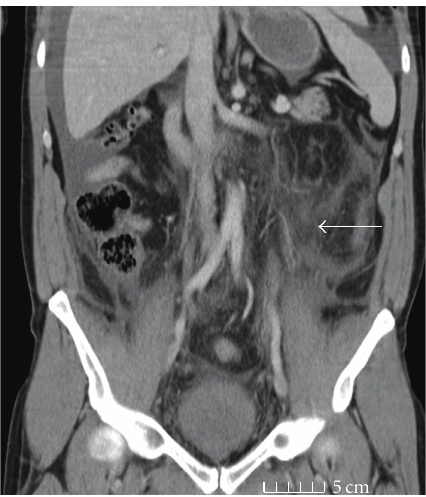
Figure 1: Coronal computerised tomography image showing di ff use inflammation a ff ecting the peritoneum of the left side of the abdomen, the pelvis and the left psoas and retroperitoneum. (Marked by white arrow).